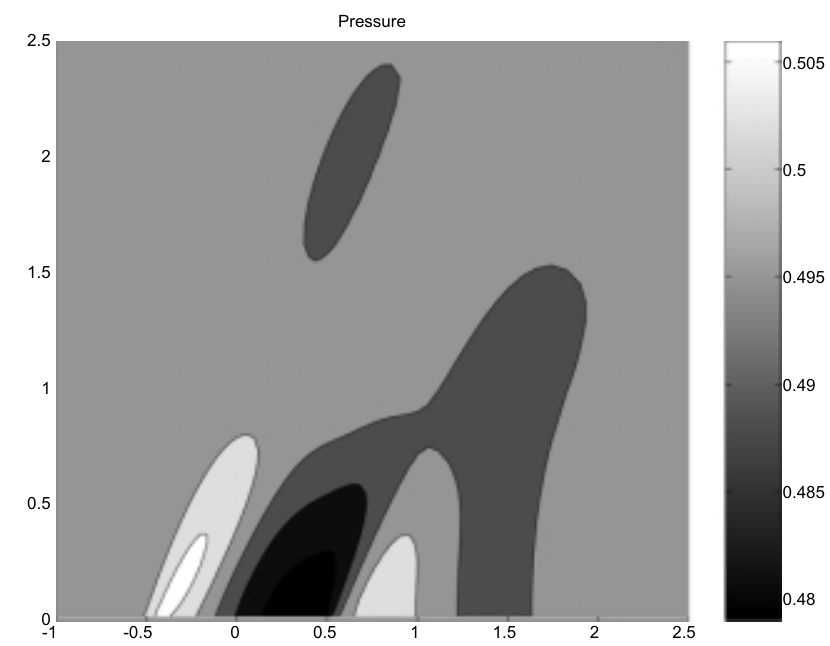
Fig. 11. Pressures after 20 second simulation using 12 modes with δ 1 = 0 . 005 .